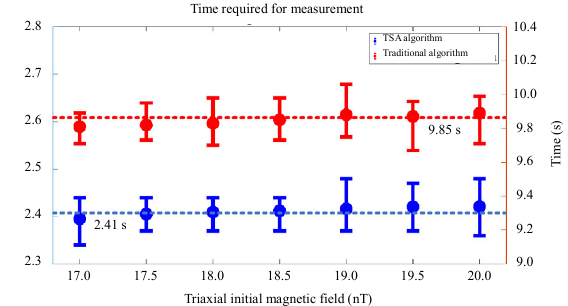
Fig. 6 Mean and error bands of the measurement times corresponding to the different measurement intervals. As can be seen from the figure, the average measurement time is around 2.41 s, which is faster than 9.85 s measured by the traditional algorithm.